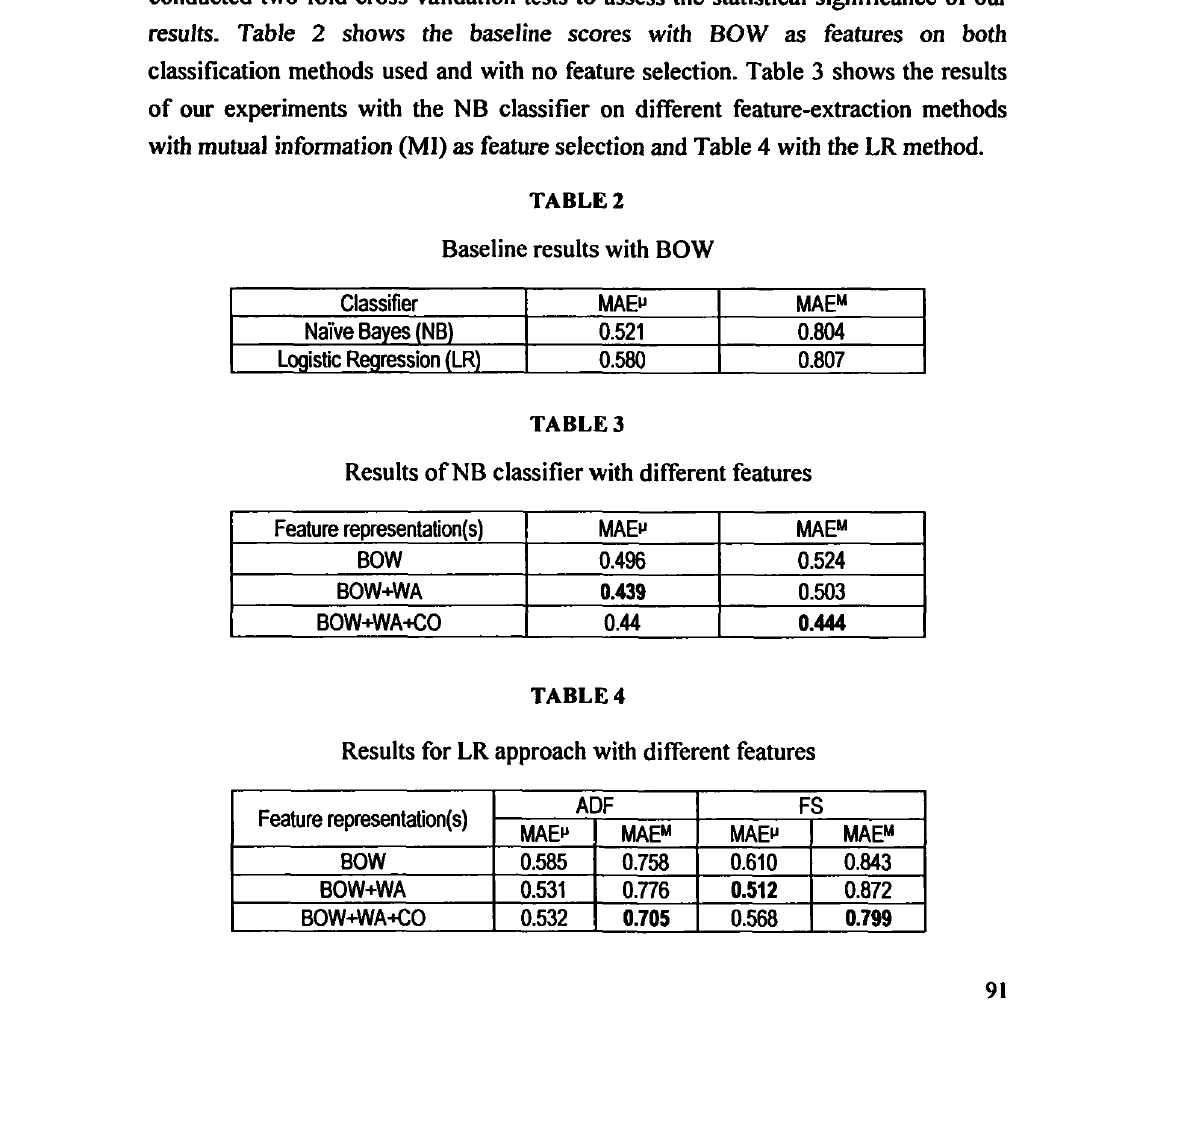
Baseline results with BOW